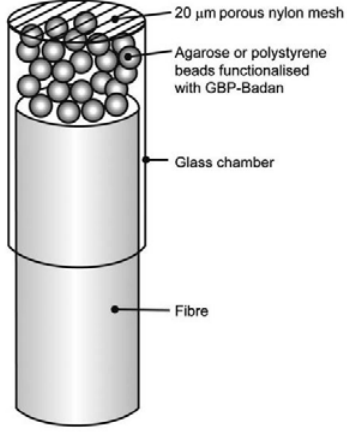
Figure 7. Multi-mode fiber optic sensor tip with beads [76].